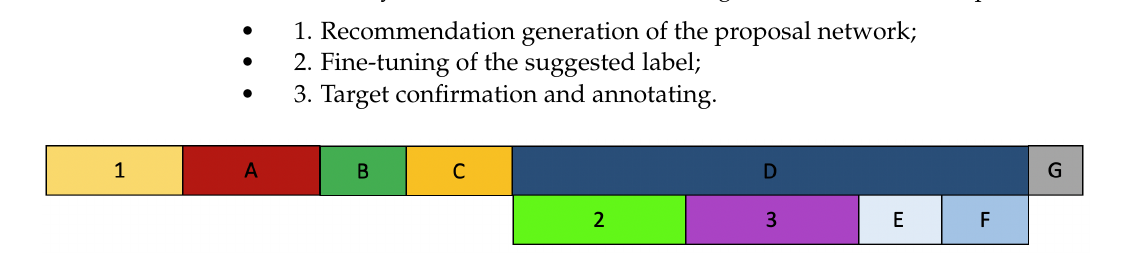
Figure 6. Auxiliary annotation method pipeline.